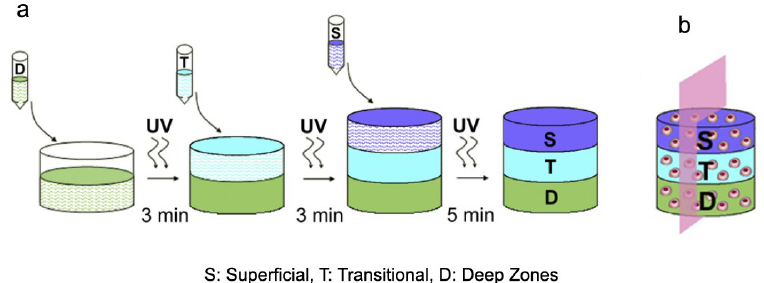
Figure 2. ( a ) Multi-layer scaffold fabrication with three distinctive layers; ( b ) Schematic of a cell laden in composite multi-layer hydrogel, reprinted with permission from [55]. Copyright 2011